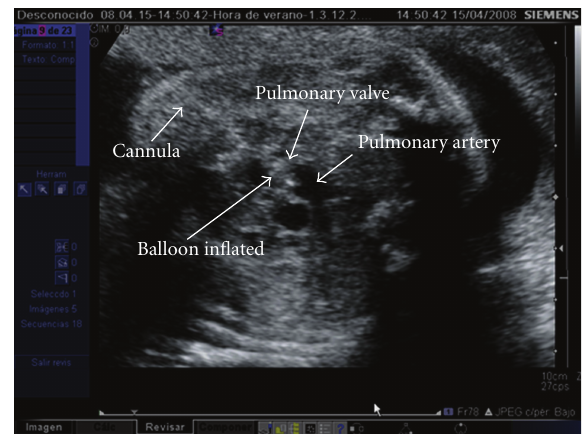
Figure 3: The coronary angioplasty balloon is inflated across the fetal pulmonary